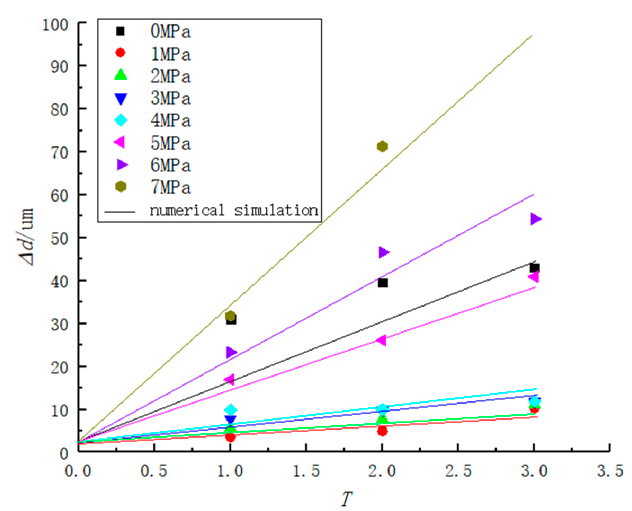
Figure 10. Numerical simulation results of fissure expansion vs. cycle number (Lines for simulation data and spots for experimental data).